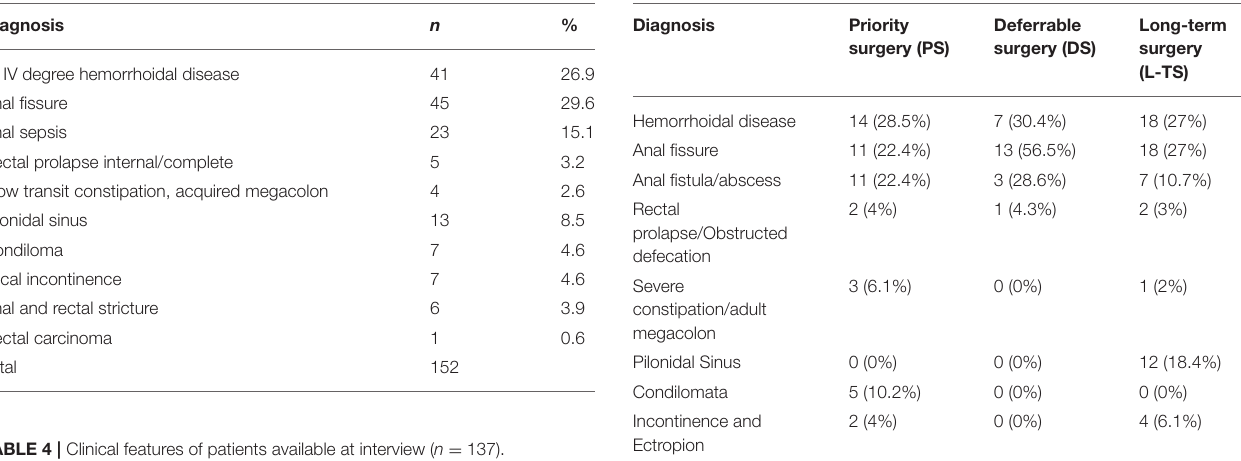
TABLE 5 | Re-scheduling surgery according to the Priority Class in 137